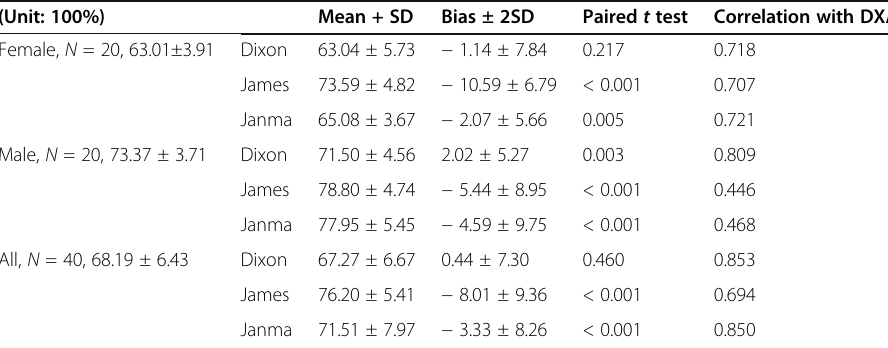
Table 2 LBM calculated using the Dixon, James, and Janma models compared with DXA as the reference standard (Unit: 100%) Mean + SD Bias ± 2SD Paired t test Correlation with DXA Female, N = 20, 63.01±3.91 Dixon 63.04 ± 5.73 − 1.14 ± 7.84 0.217 0.718 James 73.59 ± 4.82 − 10.59 ± 6.79 < 0.001 0.707 Janma 65.08 ± 3.67 − 2.07 ± 5.66 0.005 0.721 Male, N = 20, 73.37 ± 3.71 Dixon 71.50 ± 4.56 2.02 ± 5.27 0.003 0.809 James 78.80 ± 4.74 − 5.44 ± 8.95 < 0.001 0.446 Janma 77.95 ± 5.45 − 4.59 ± 9.75 < 0.001 0.468 All, N = 40, 68.19 ± 6.43 Dixon 67.27 ± 6.67 0.44 ± 7.30 0.460 0.853 James 76.20 ± 5.41 − 8.01 ± 9.36 < 0.001 0.694 Janma 71.51 ± 7.97 − 3.33 ± 8.26 < 0.001